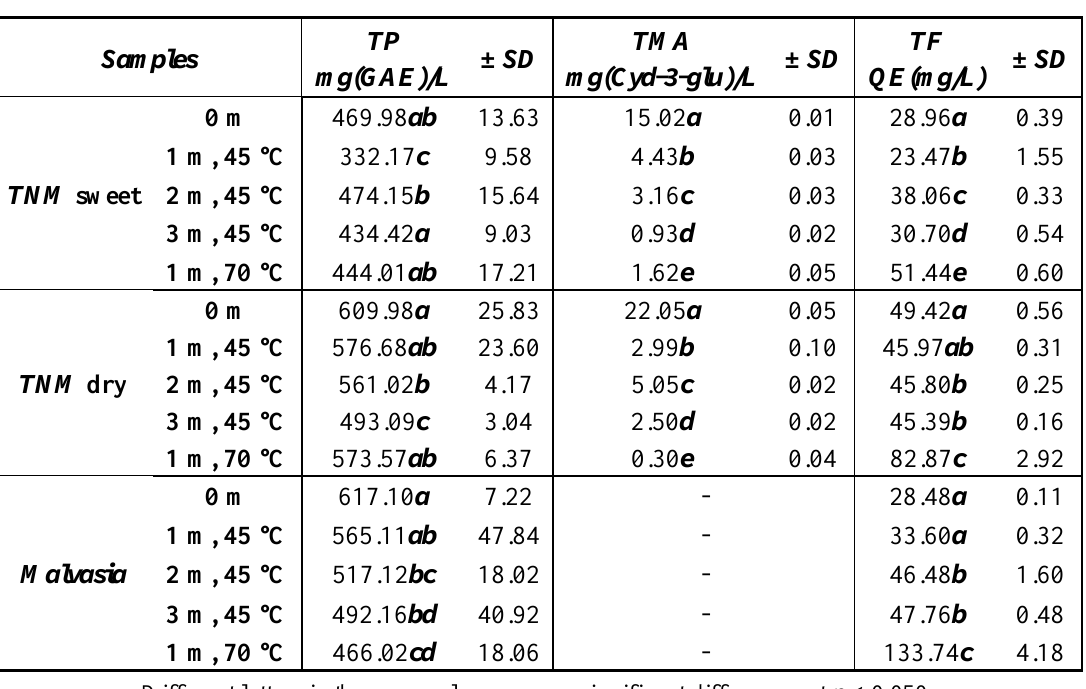
Table 1. Total polyphenols (TP), total flavonoids (TF) and total monomeric anthocyanins (TMA) in Madeira wines at the initial stage and at the end of each month of heating at 45 °C (3 months) and 70 °C (1 month).